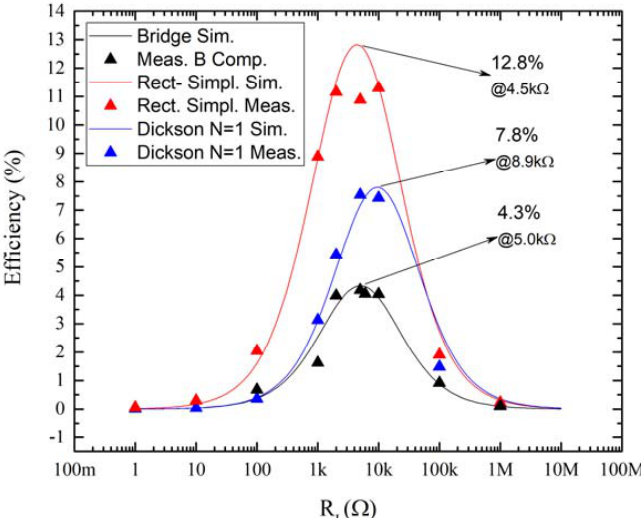
Figure 5. ADS-harmonic balance simulated (blue, red, and black lines) and measured (blue, red, and black dots) efficiencies for simple diode-capacitor rectifier, four-diode Bridge rectifier, and the first- order Dickson–Greinacher rectifier circuits. 𝑃 (cid:3036)(cid:3041) = −30 dBm . The optimal efficiencies and 𝑅 (cid:3013) values for each rectifier are